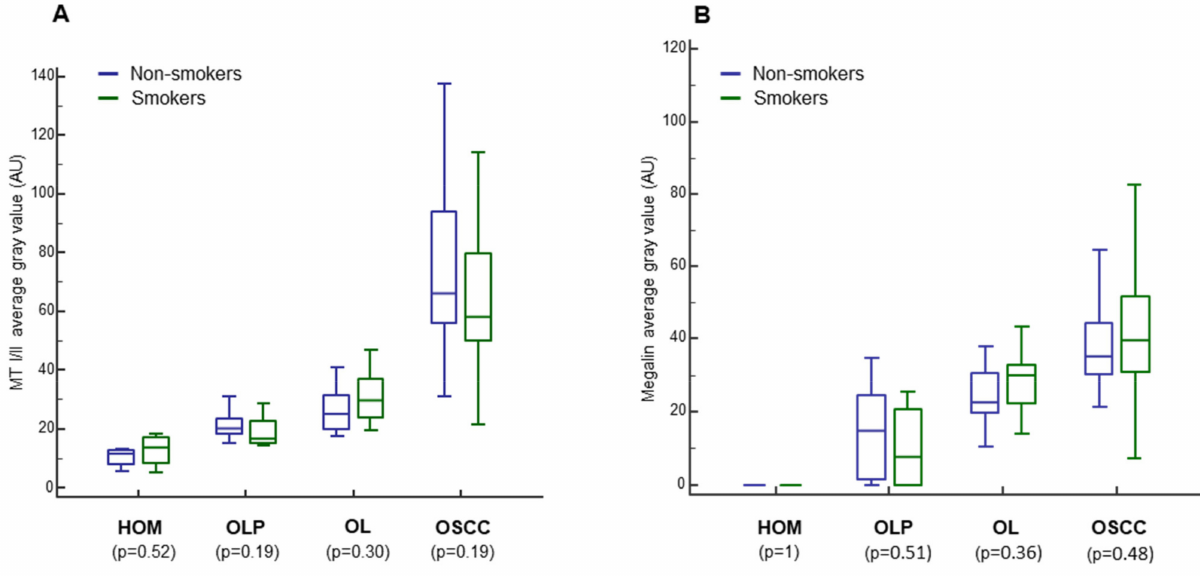
Figure 7. Impact of smoking habit on metallothionein I/II ( A ) and megalin ( B ) expression. The measurements were made by ImageJ software and data are expressed in arbitrary units (AU) as the median of average gray values with range. HOM, healthy oral mucosa; OLP, oral lichen planus; OSCC, oral squamous cell